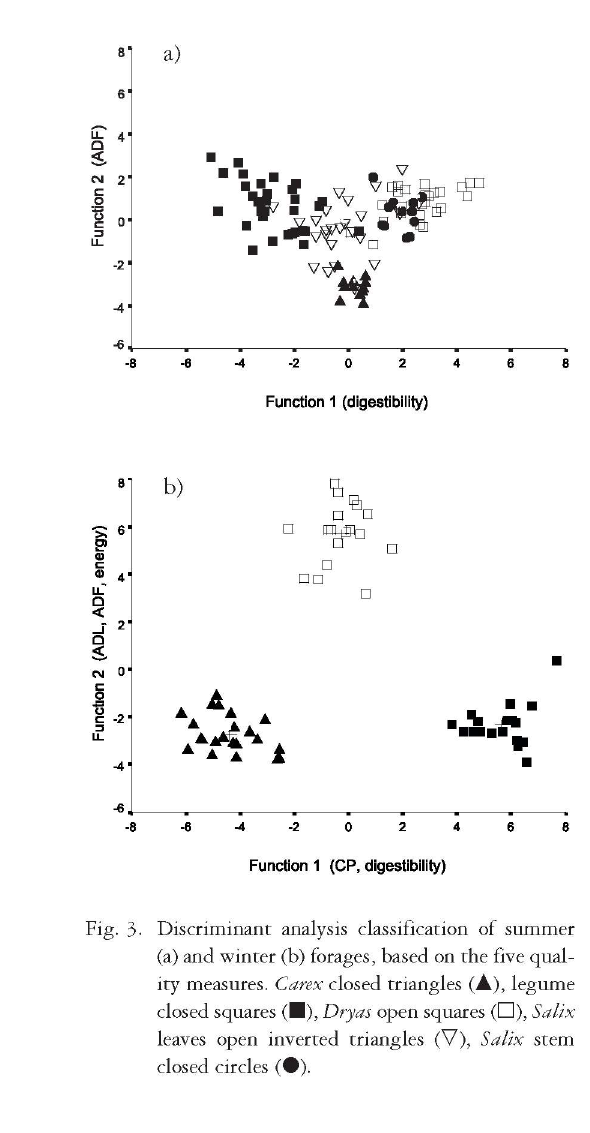
Fig. 3. Discriminant analysis classification of summer (a) and winter (b) forages, based on the five qual¬ ity measures. Carex closed triangles (A), legume closed squares (B), Dryas open squares (•), Salix leaves open inverted triangles (V), Salix stem closed circles